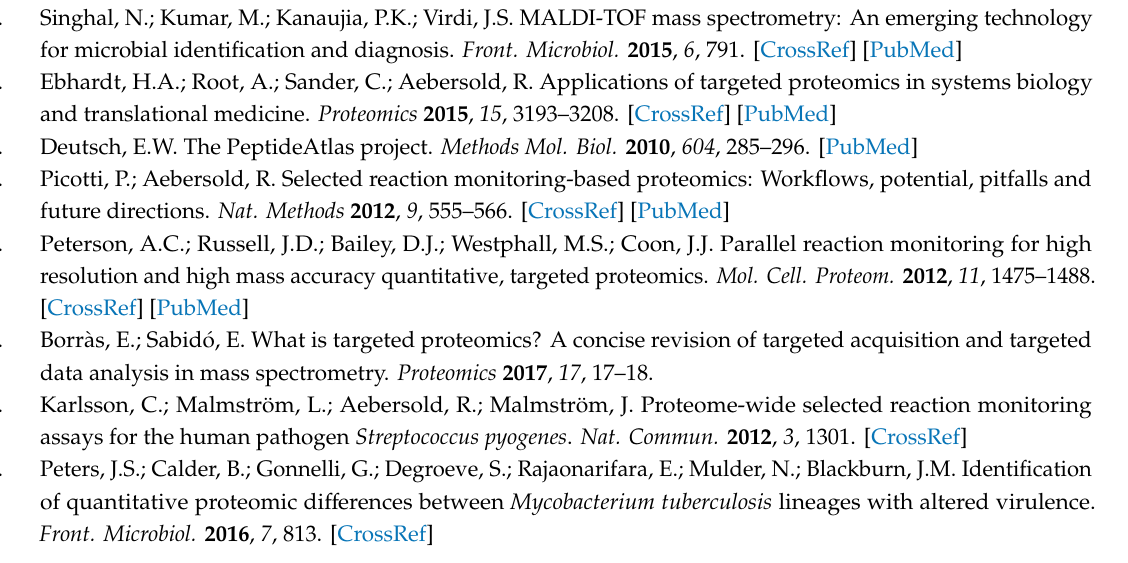
Table S1: Genome sequence similarities of cowpox virus; Table S2: Number of peptides from CPXV Brighton Red strain processing; Figure S1: Number of shared peptides by species for VACV Western Reserve; Figure S2: Histogram and density plot of homologous consensus—CPXV; Data S1: MSA of the pre-glycoprotein polyprotein GP complex (GPC gene); Data S2: MSA of nucleocapsid protein (N gene); Data S3: MSA of RNA-directed RNA polymerase L (L gene); Data S4: MSA of RING finger protein Z (Z